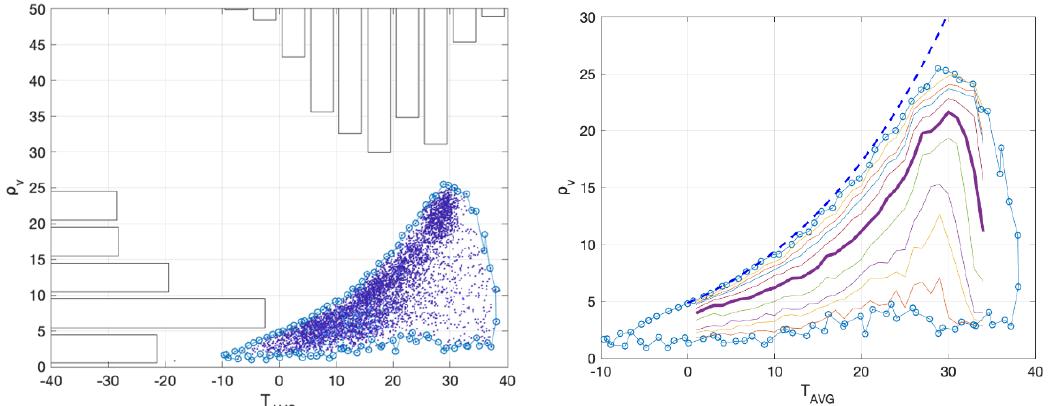
Figure 3. Temperature and humidity conditions for all reported COVID-19 human cases worldwide (01/01/2020– 07/05/2020). In the same figure, univariate histograms of the scattered-data are plotted. The frequency of the joint distribution is given in Table 2 [left]. Percentiles (1, 5, 10, 25, 50, 75, 90, 95, 99) of humidity as a function of temperature for all reported COVID-19 human cases worldwide (01/01/2020–07/05/2020). The thickest line corresponds to the median. In the same figure, the maximum possible value of humidity at each temperature, estimated from the Clausius-Clapeyron equation, is plotted with the dotted line